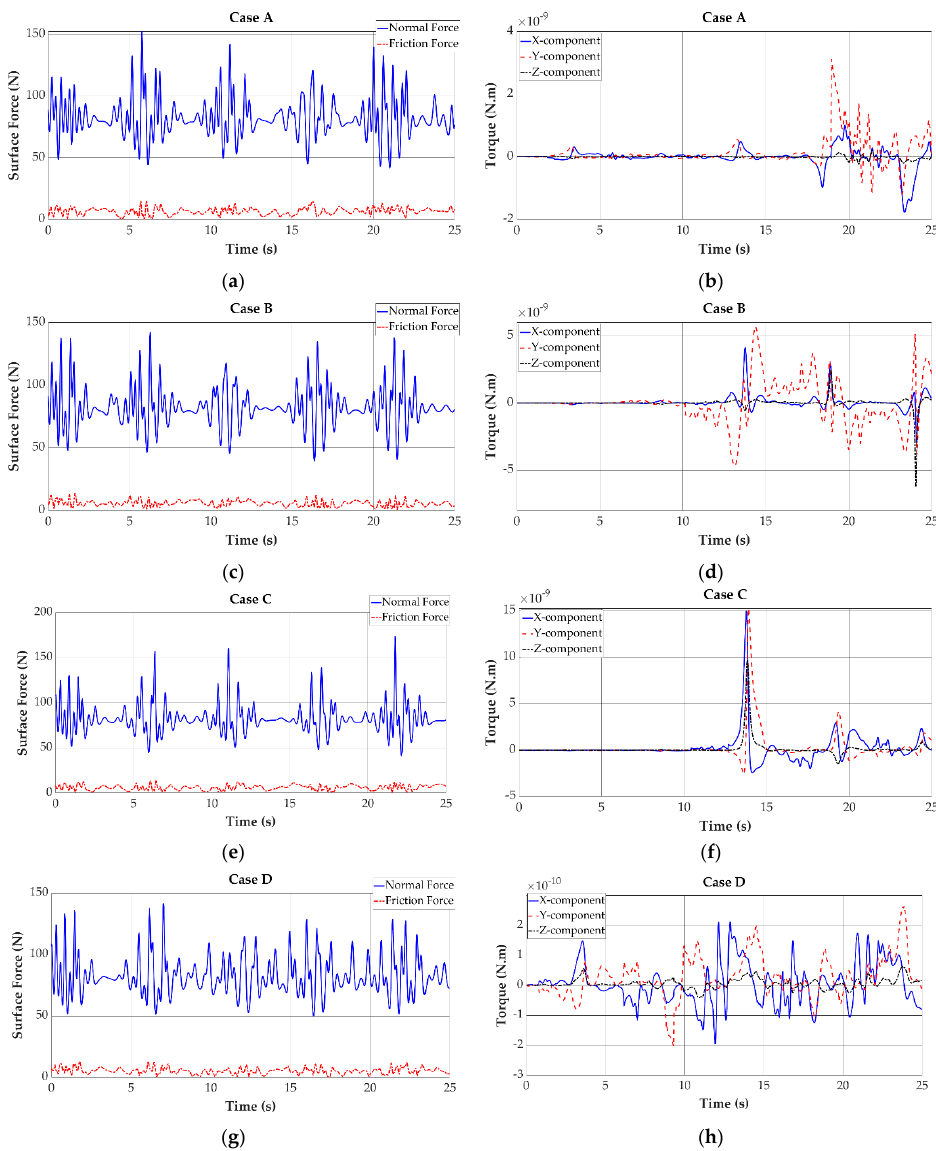
Figure 6. Example 1. Magnitude of normal and frictional forces provided by the surface to the shell at P on the left and the computed torque T P on the right. ( a , b ) Case A, ( c , d ) Case B, ( e , f ) Case C, XYZ ( g , h ) Case D.